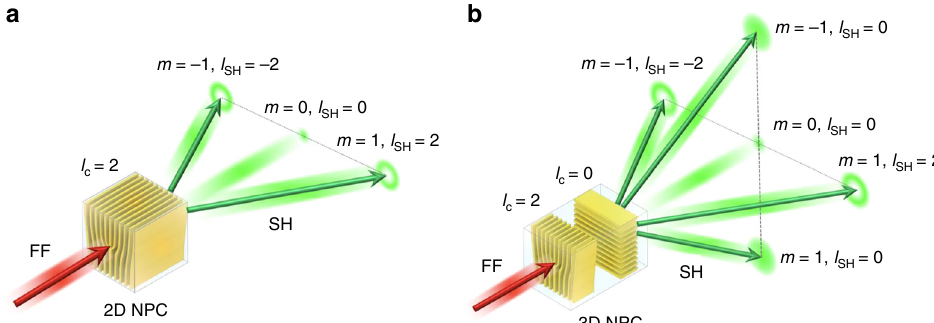
Fig. 1 Illustrating the concept of nonlinear wavefront shaping in nonlinear photonic crystal (NPC). a The 2D NPC contains region of fork-type spatial χ (2) nonlinearity modulation. When illuminated by a strong Gaussian fundamental beam (FF) the crystal generates second harmonic (SH) wave in form of multiple optical vortices, i.e., donut beam with spiral phase front. The symbols m , l c , and l SH represent nonlinear diffraction order, topological charges of the fork structure and the optical vortices, respectively. b Being superior to the lower-dimensional structures, a 3D NPC may contain versatile multilayered χ (2) modulation patterns leading to SH emissions in multiple directions with different wavefronts. Here for simplicity we depict a two-layer structure comprising the fork and one-dimensional grating for generation of donut and Gaussian SH